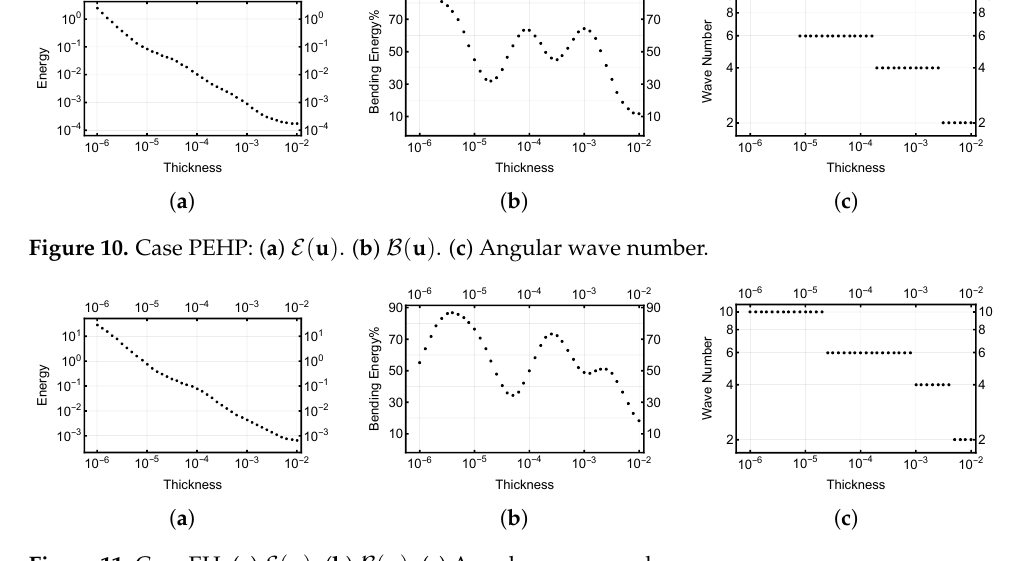
Figure 11. Case EH: ( a ) E ( u ) . ( b ) B ( u ) . ( c ) Angular wave number.